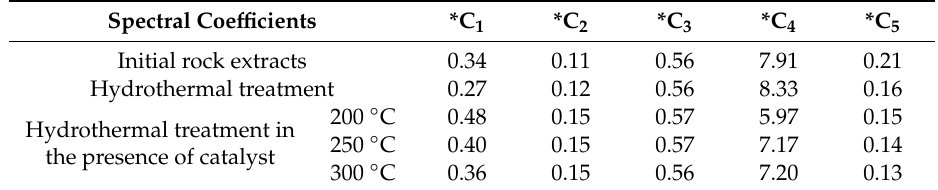
Table 3. FTIR spectral coefficients of rock extracts.